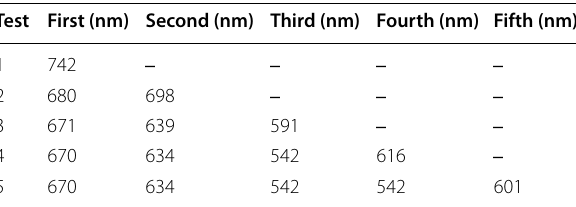
Table 2 Depth variation of each indentation during the one array indentations with the rotation angle of 0° and the spacing of 2 μm